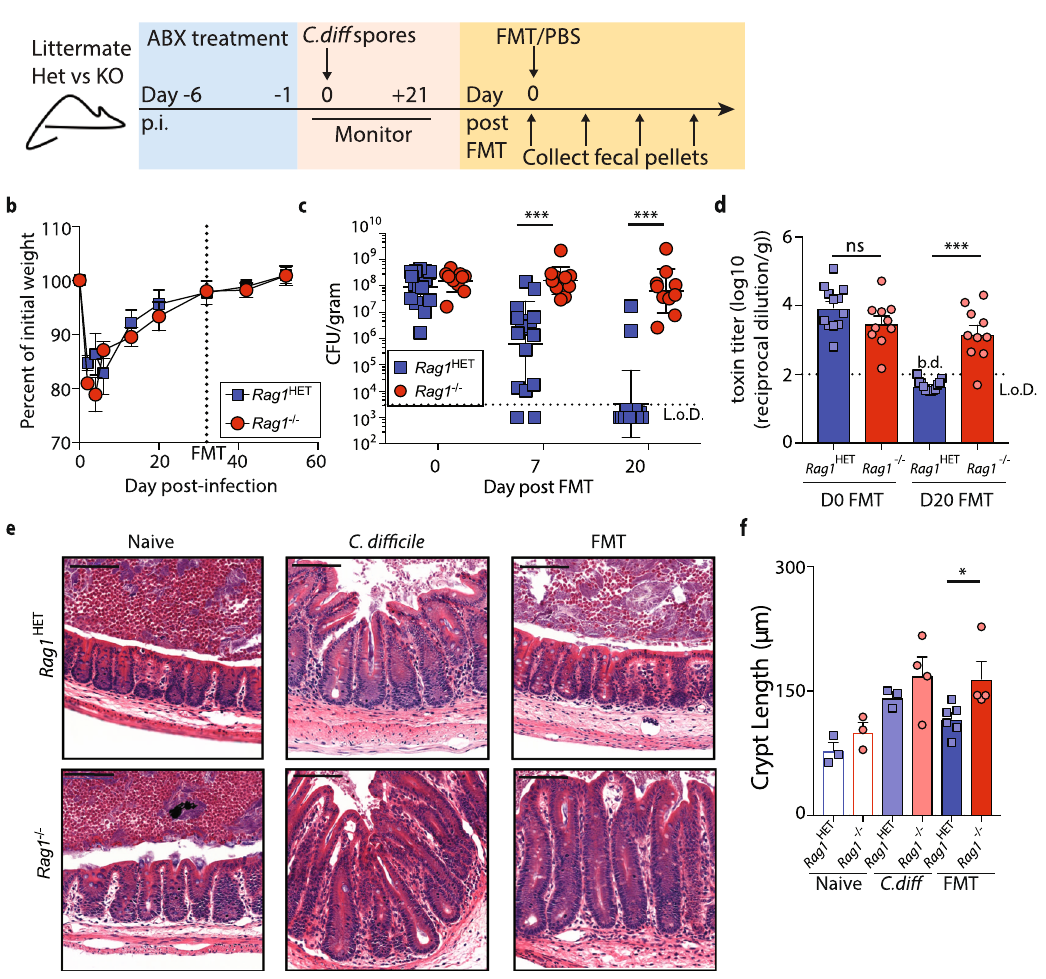
Fig. 1 Immunode fi cient Rag1 − / − mice exhibit impaired resolution of C. dif fi cile infection following FMT. a Schematic of antibiotic (ABX)